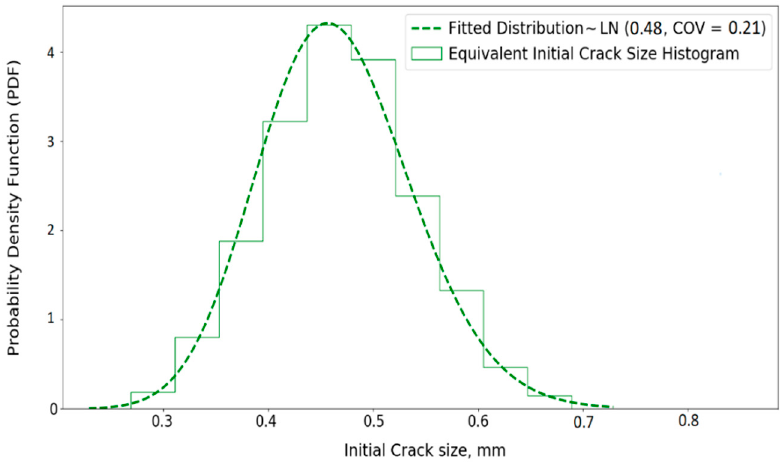
Figure 6. Equivalent initial crack size histogram and the fitted distribution.